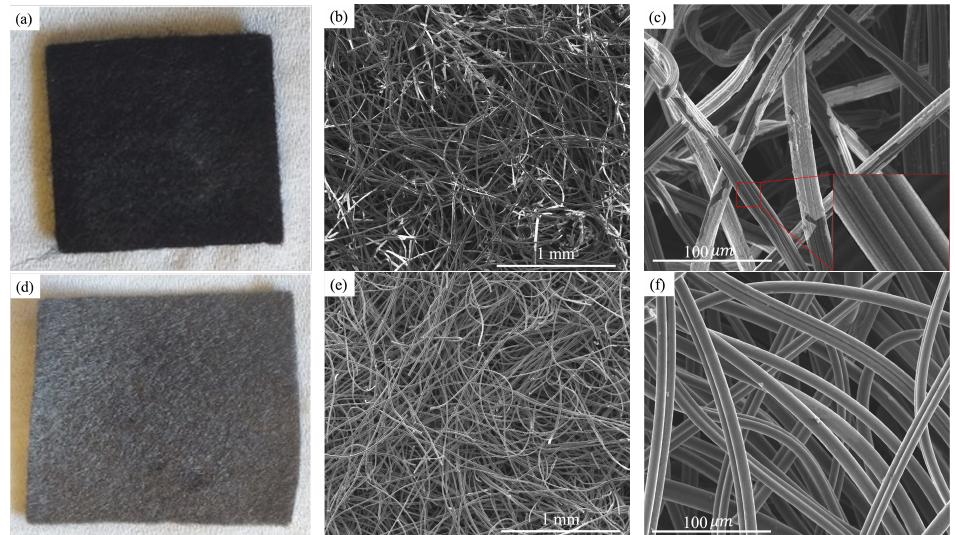
Figure 2. Photographs of the used carbon felts: ( a ) commercial (CCF) and ( d ) activated (ACF) and their SEM images: CCF surface at ( b ) 1 mm and ( c ) 100 µ m scales, where the white regions are the NaCl deposited, and ACF surface at ( e ) 1 mm and ( f ) 100 µ m